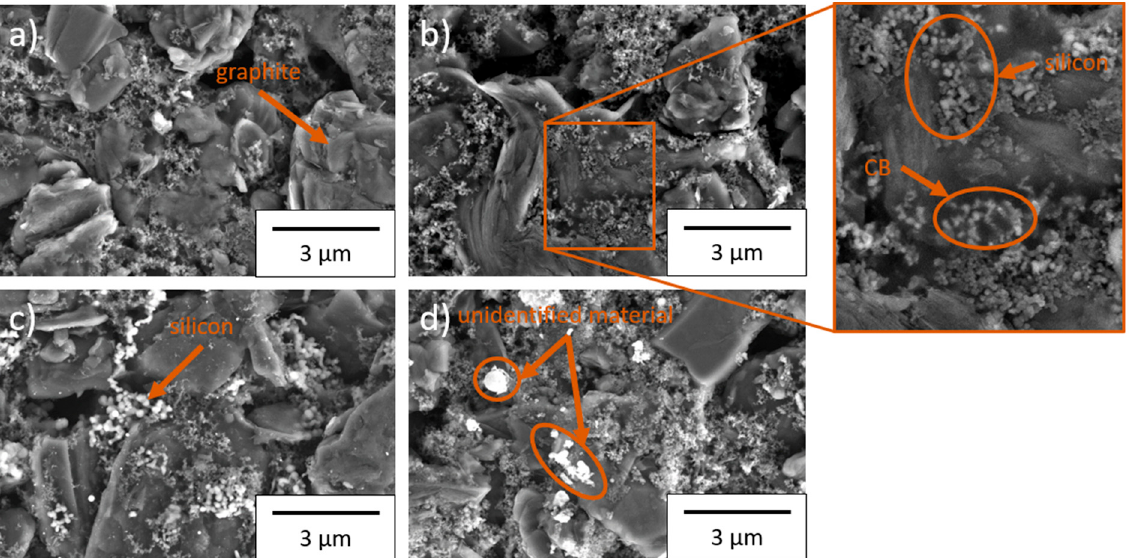
Figure 3. Scanning electron microscope images of the electrode surface at 10,000 × magnification: ( a ) without silicon, ( b ) TSi, ( c ) NGP, and ( d ) SSN. Table 4. Chemical composition of the manufactured electrodes measured by ICP-OES and CGHE.